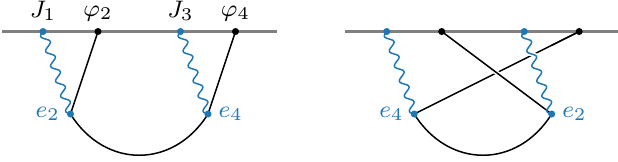
Figure 6: Illustration of the s - and t -channel contributions to the Abelian Compton